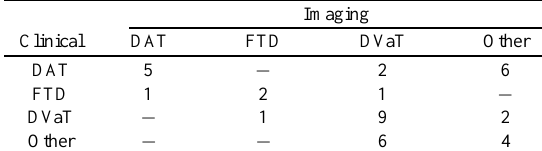
Table 3 Clinical and SPECT scan classification of patients using data from the neuroimaging